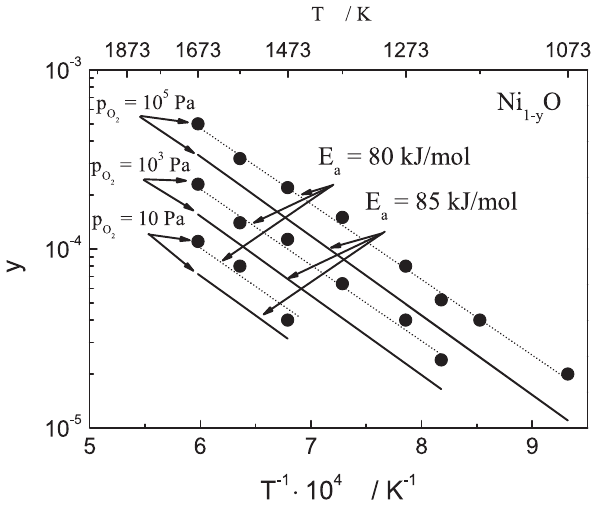
Fig. 1: Temperature dependence of nonstoichiometry, y, in Ni 1-y O, determined experimentally using gravimetric method (symbols) on the background of calculated dependence (solid lines) presented in Arrhenius plot.